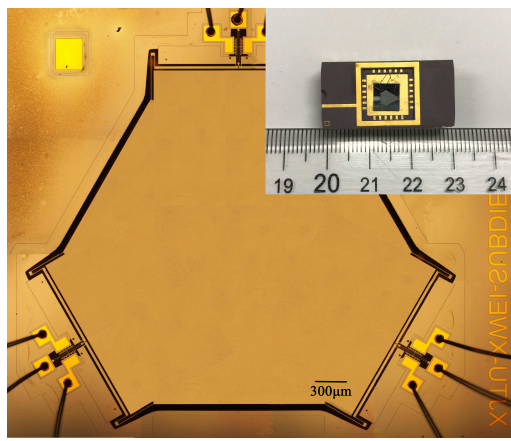
Figure 5. Micrograph of the tilt sensor and package of the